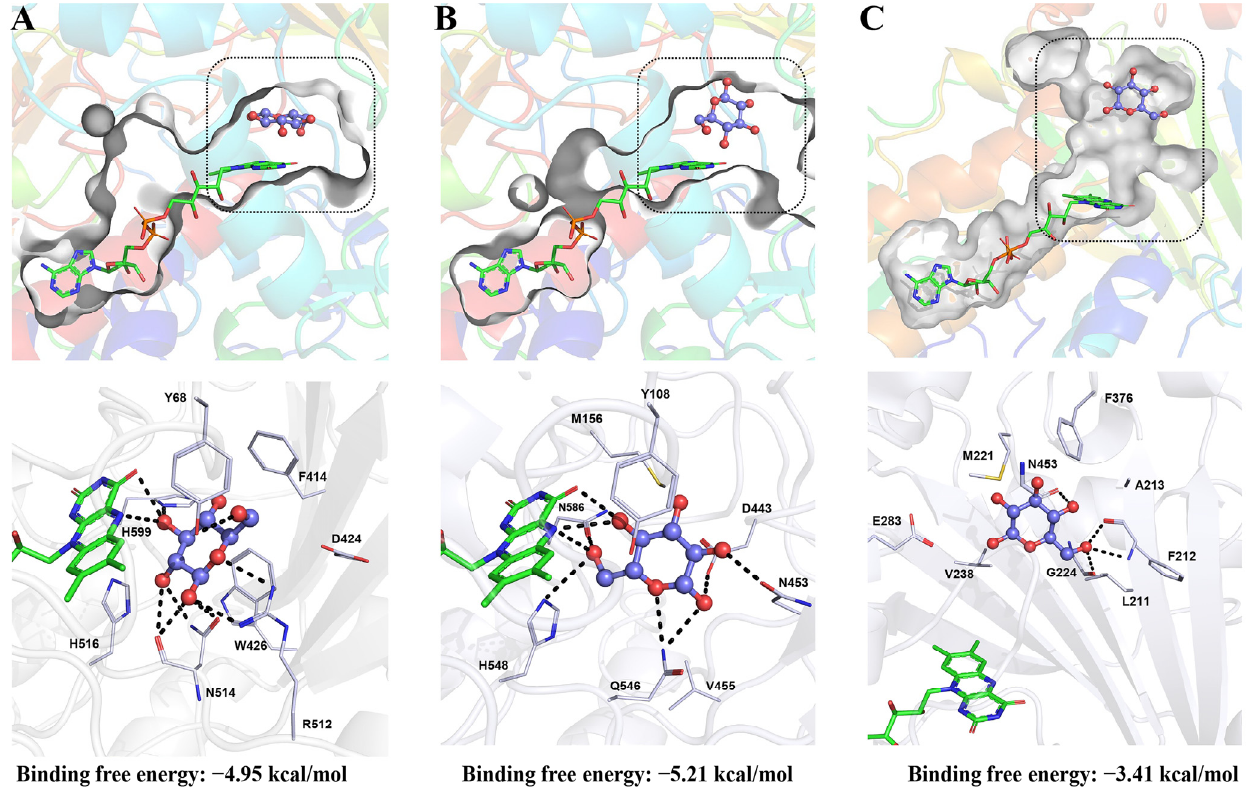
Figure 4. The crystal structure and substrate binding pocket of GOD from Aspergillus niger ( A ) with Heliothis viriplaca ( B ) and Citrobacter freundii ( C ) with the binding free energy. The predictive substrate binding pockets are shown in dotted boxes.